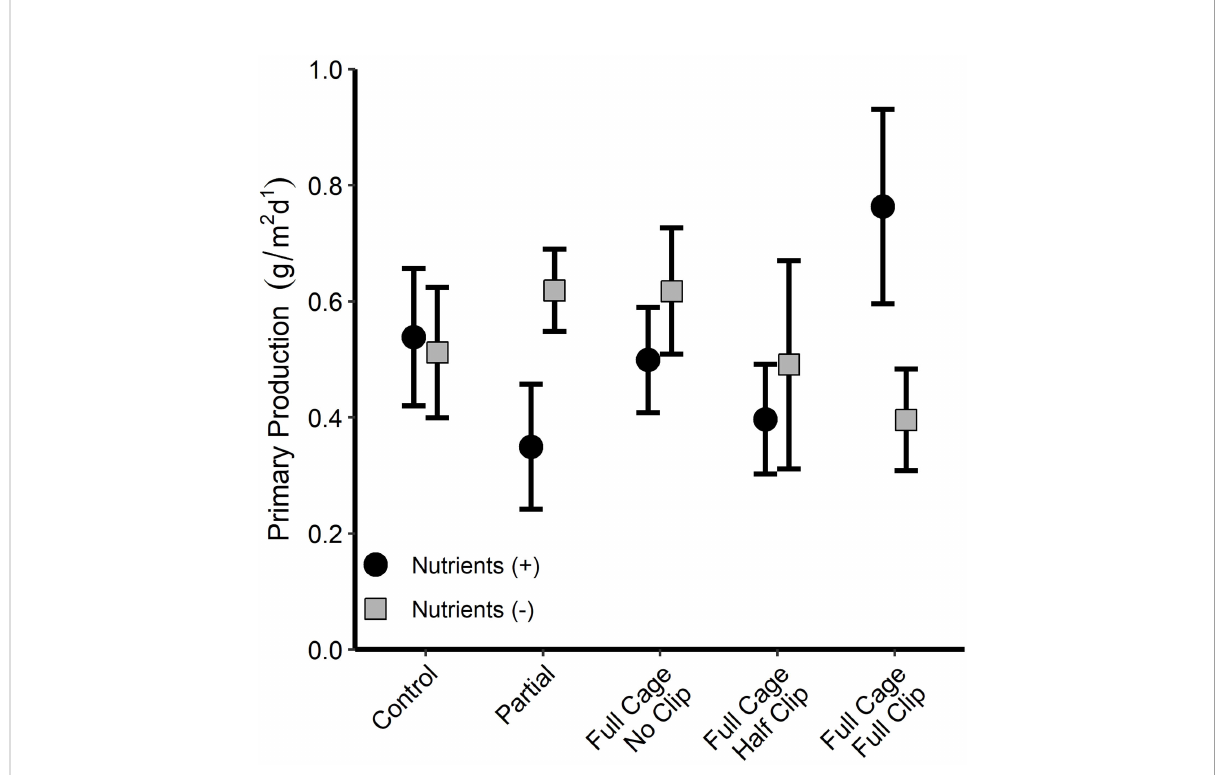
FIGURE 6 Mean Thalassia testudinum primary production values (± 1 SE) 4 months into the caging study. Full exclusion cage treatments also contained simulated grazing treatments. No clip = no clipping treatment. Half clip = top half of leaf clipping treatment. Full clip = fully clipped leaves (~1-2 cm above the sediment).